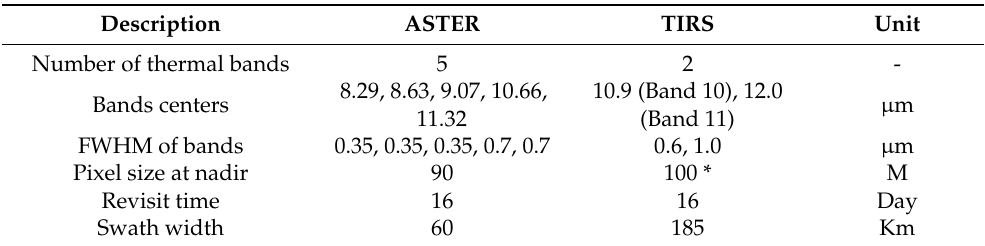
Table 1. ASTER and TIRS bands features; * TIRS bands are acquired at 100 m spatial resolution but are resampled to 30 m in delivered data product.